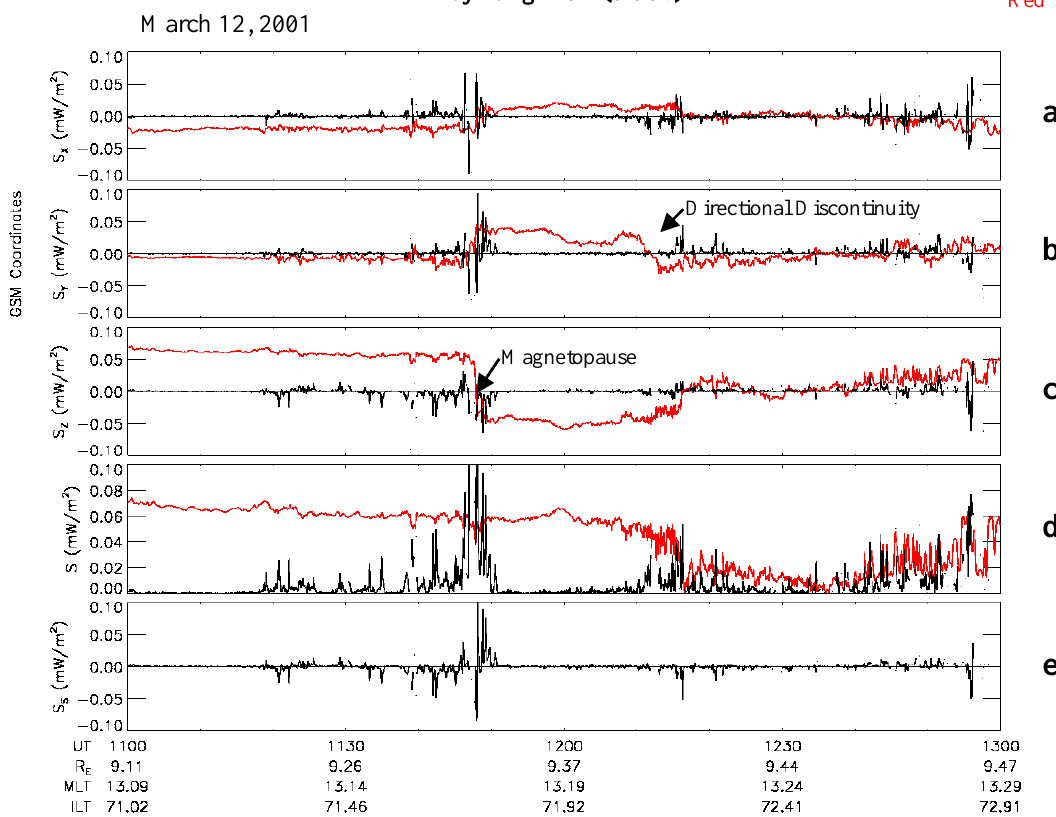
Fig. 9. Wave Poynting flux calculated from 1 E × 1 B and overlaid on the magnetometer traces (red), to provide context, for the 12 March 2001